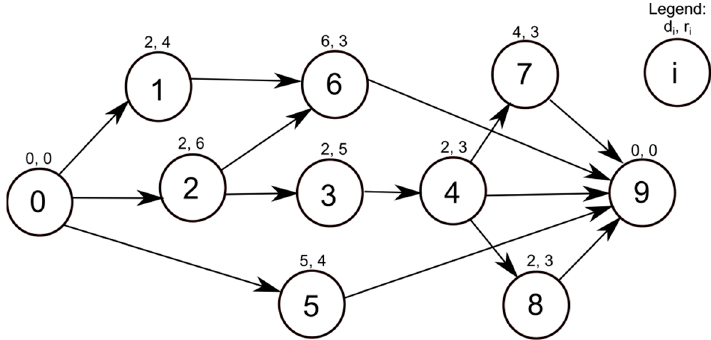
Figure 1. Example of project in activity-on-node (AON) representation.